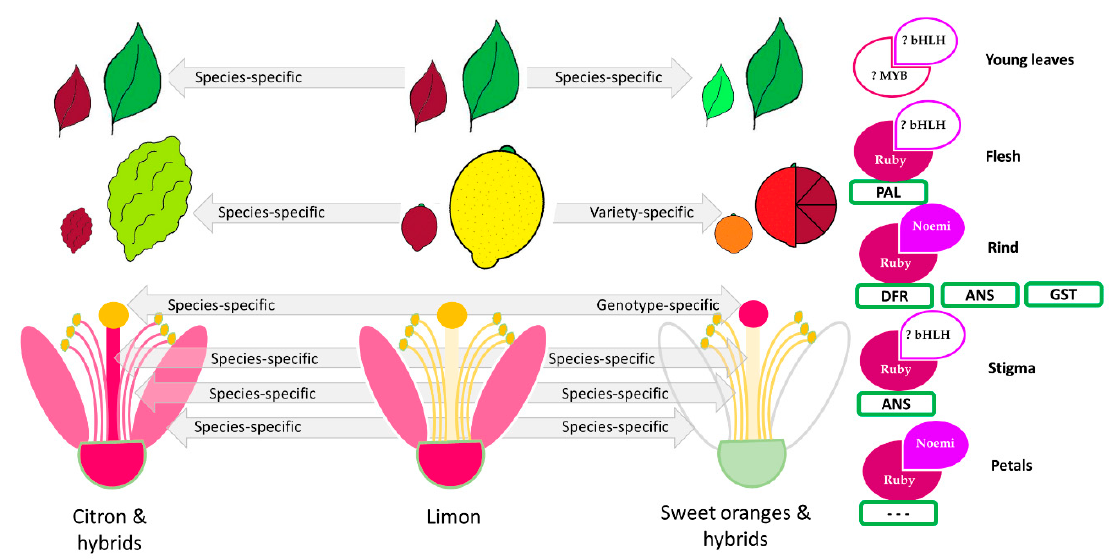
Figure 12. A model illustrating the putative inheritance of anthocyanin pigmentation in tissues of the main Citrus species and hybrids considered in this study. A scheme of leaves, fruits, and flowers tissue pigmentation is shown. A representation of transcription factors (Ruby and Noemi), biosynthetic genes (PAL, dihydroflavonol 4-reductase (DFR), anthocyanidin synthase (ANS), glutathione S- transferase (GST)) and their relationship based on the qualitative statistical analysis describing the difference between pigmented and non-pigmented samples in tissues is